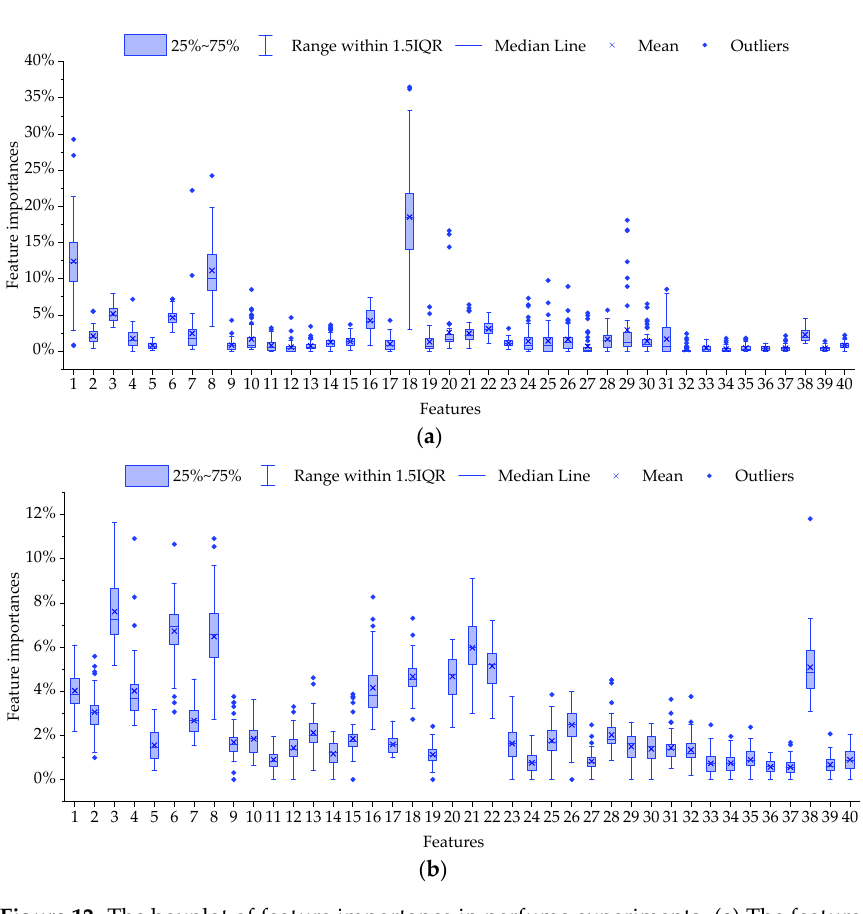
Figure 12. The boxplot of feature importance in perfume experiments. ( a ) The feature importance obtained by XGBoost; ( b ) The feature importance obtained by LightGBM.